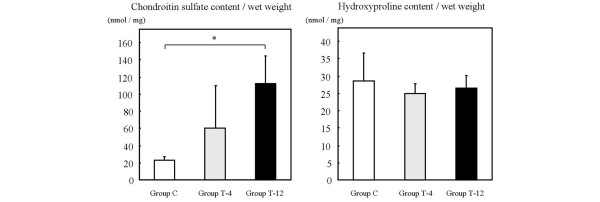
Bar graphs representing cartilage constituents in rabbits with cartilage defects given cell/scaffold implants. Group with control (untreated) defects (group C); and groups given tissue-engineered cartilage implants at 4 weeks after implantation (group T-4) and 12 weeks after implantation (group T-12). Error bars represent standard deviations. *P < 0.05 on the nonparametric Mann–Whitney U test.